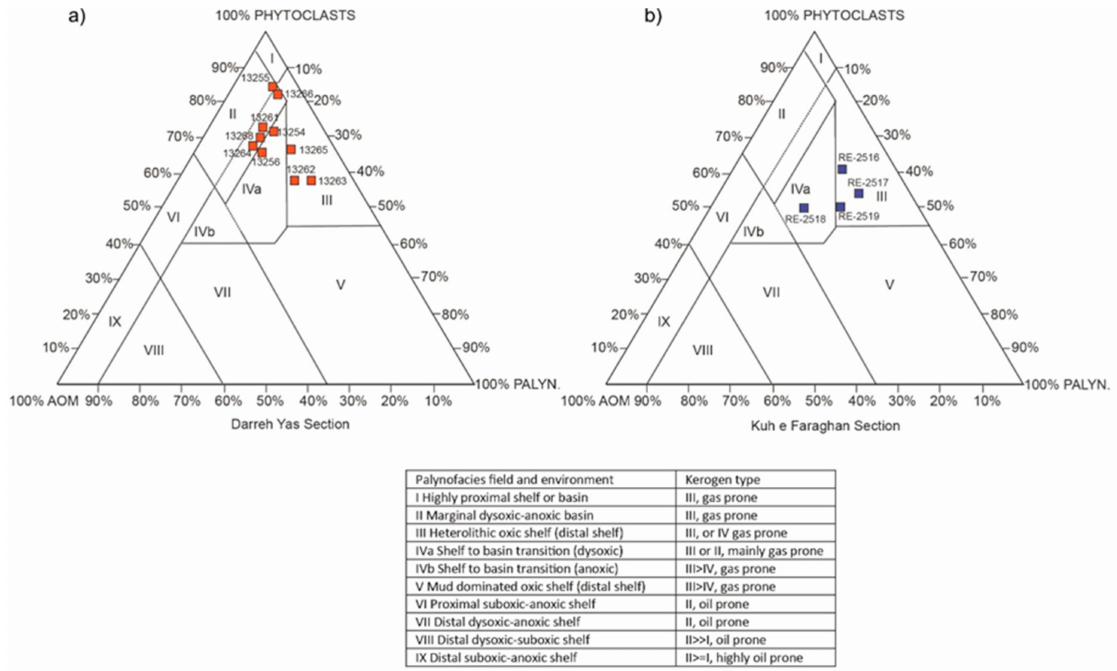
Figure 4. AOM-Phytoclast-Palynomorph plotted on the Tyson’s ternary diagram of the Faraghan Formation at the Darreh Yas ( a ) and Kuh e Faraghan ( b )